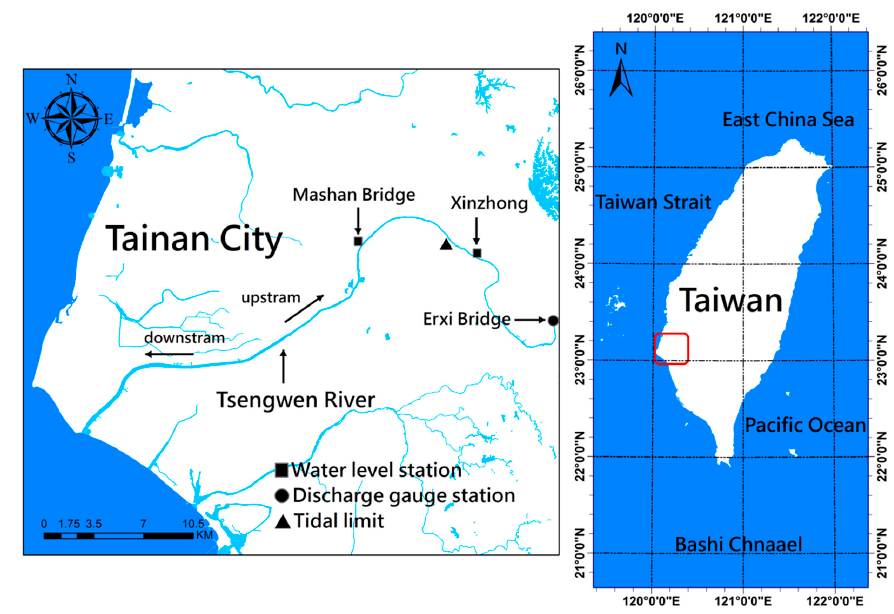
Figure 1. Maps of the study area (white, blue, and cyan represent land, ocean, and river,